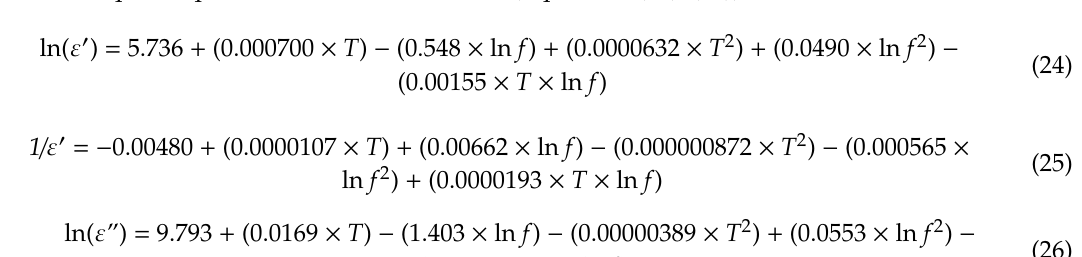
Table S5. The transformation form of ln ε (cid:48)(cid:48) and 1 / ε (cid:48)(cid:48) is used for the dielectric constant (Equation (27)) and the loss factor (Equation